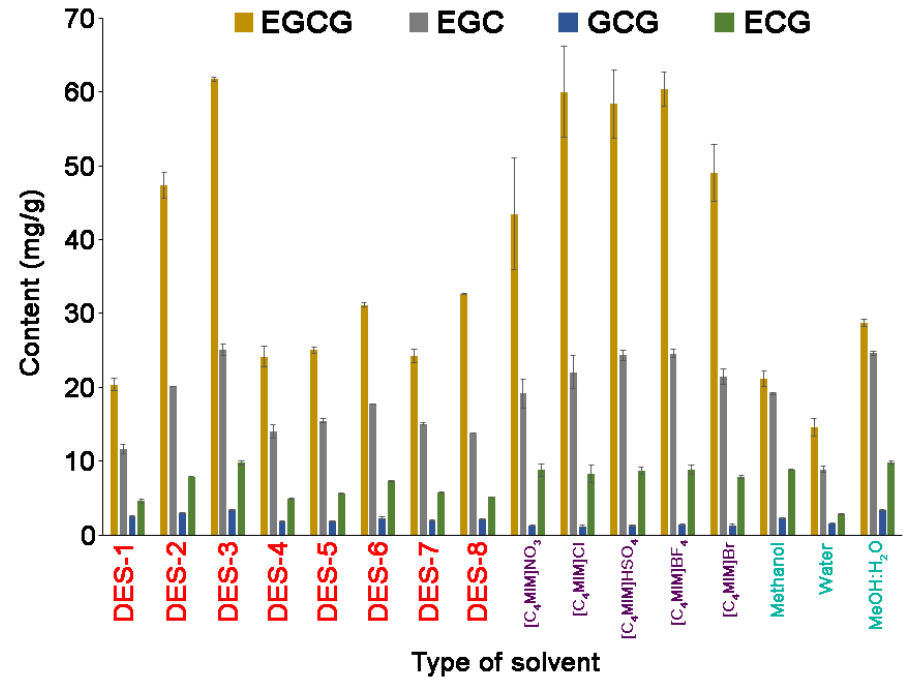
Figure 1. A comparison of the deep eutectic solvents (DESs), ionic liquids (ILs) and conventional solvent extraction efficiency of catechins.